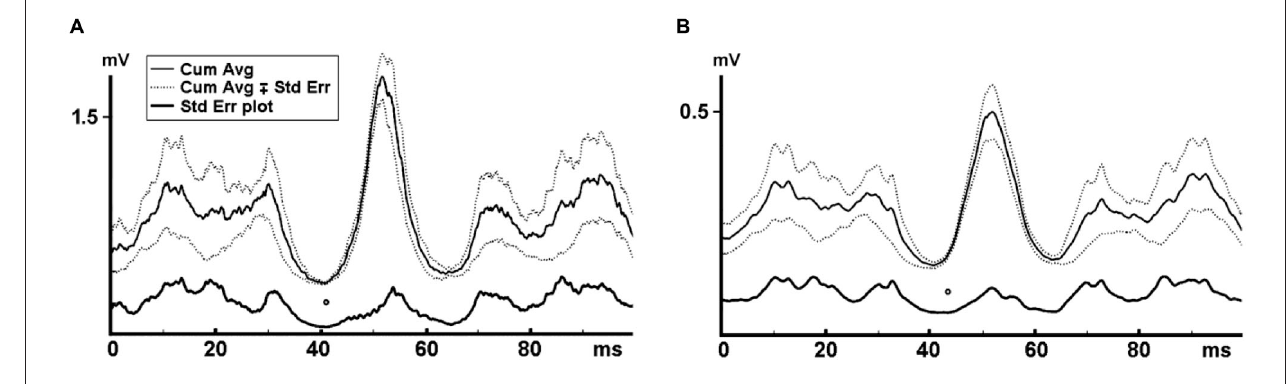
shown with an empty circle. (A) Indicates the MMU data and (B) shows the SEMG data. Reflex latency for the MMU data was 38.0 ms and 40.0 ms for the SEMG data.